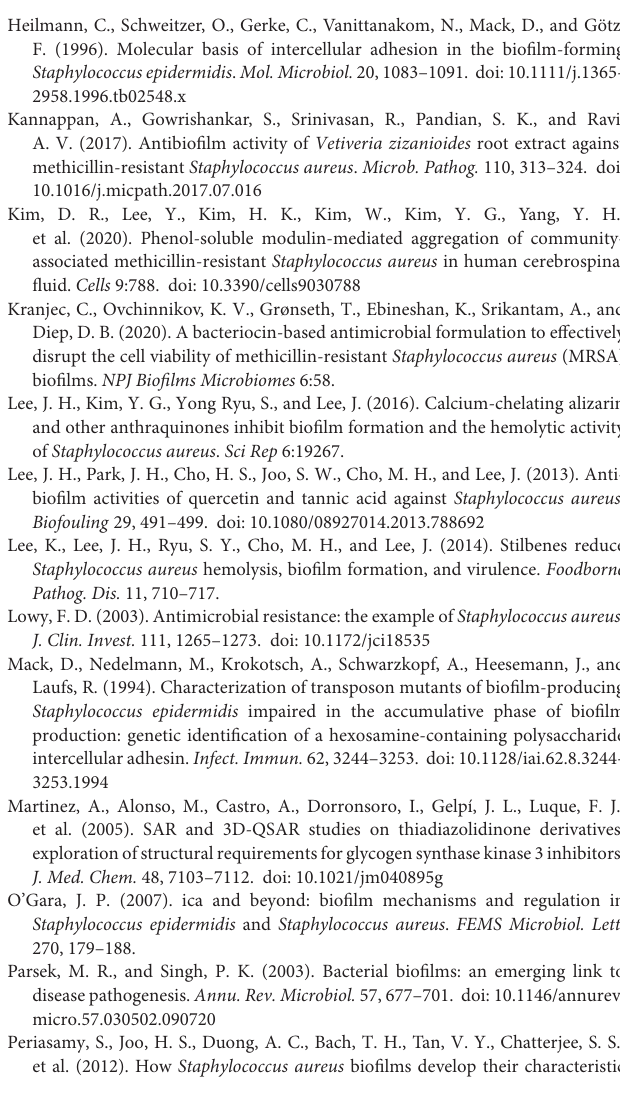
Supplementary Figure 1 | Growth curves of S. aureus strains cultured with ZY-214-4 ( > 4 µ g/ml). Supplementary Figure 2 | NMR identification of